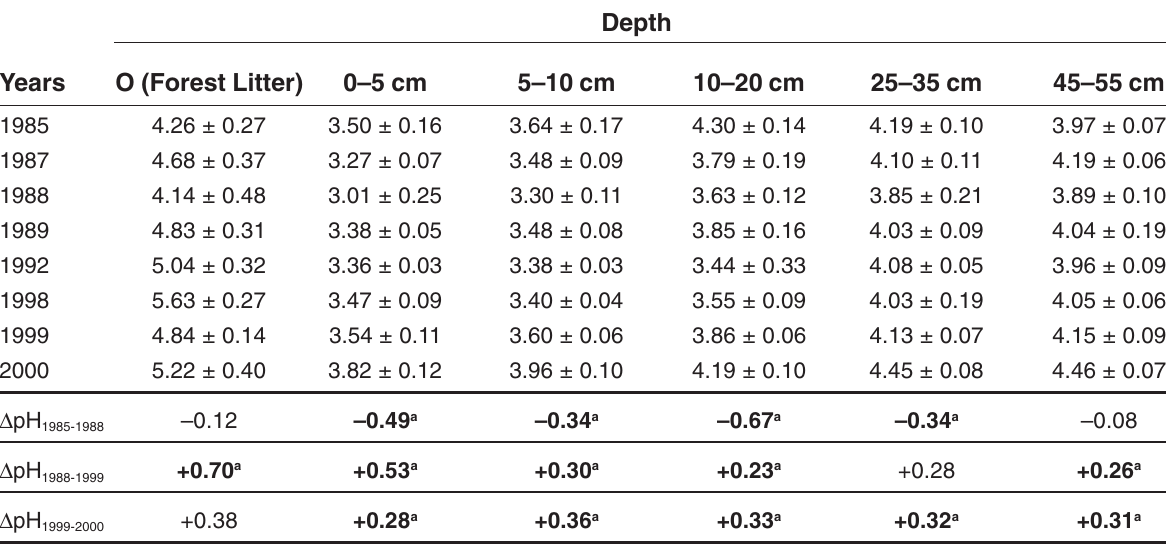
Mean pH Changes in Luvisols at a 0.2-km Distance from the JV Achema Plant KCl